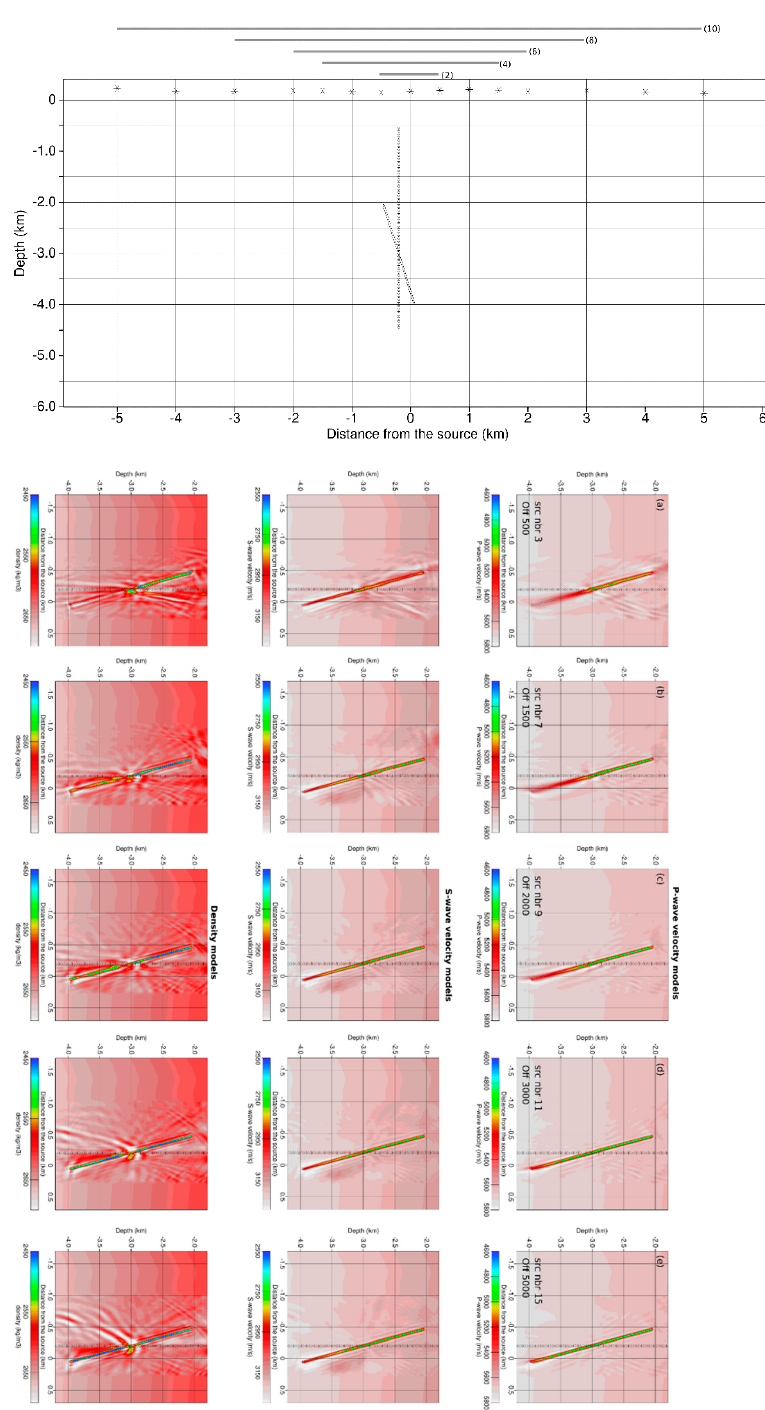
Figure 6. In the top panel, a simplified sketch showing the acquisition geometry used for each experiment is indicated by the number in-brackets. The modeled physical models remain unchanged throughout the different experiments whereas the number of sources changes. In the bottom panel, the physical models recovered from the sensitivity study of the acquisition geometry. At the top, we show P-wave field, in the middle S-wave field and at the bottom the density model. According to the Table 1, we show the results obtained from experiments 2 ( a ), 4 ( b ), 6 ( c ), 8 ( d ) and 10 ( e ). The inverted triangles are the receivers, and the black polygons follow the fault trace. The results are shown only in the target